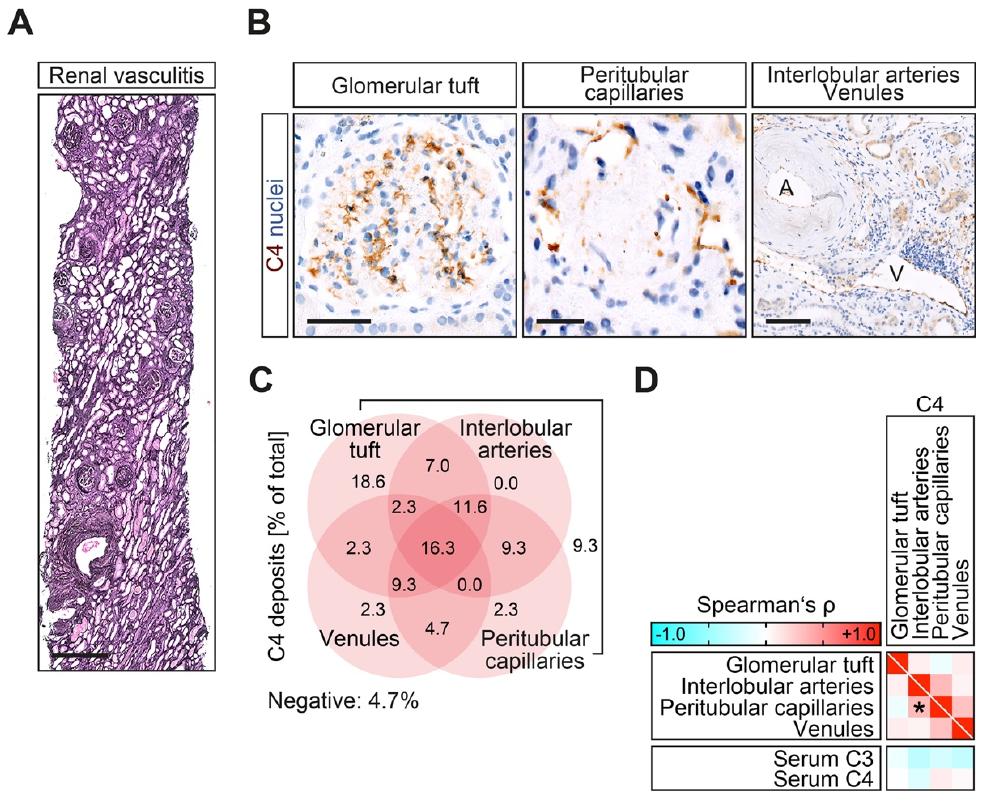
Figure 1. Complement C4 deposits localize to distinct vascular compartments and associate with clinicopathological characteristics in ANCA-associated renal vasculitis. ( A , B ) Representative photomicrographs of silver stain and complement C4 with hematoxylin counterstain in the glomerular tuft with typical mesangiocapillary pattern, peritubular capillaries, interlobular arteries ( A ), and venules (V), scale bars from left to right: 500 μ m, 25 μ m, 50 μ m, and 100 μ m. ( C ) The presence of complement C4 deposits in the glomerular tuft, interlobular arteries, peritubular capillaries, and venules is presented as a percentage (%) of the total. ( D ) Association between the localization of C4 deposits and serum levels of C3c and C4 in ANCA-associated renal vasculitis are shown by heatmap reflecting mean values of Spearman’s ρ . The asterisk (*) indicates a significant association in the univariate analysis ( p < 0.05).